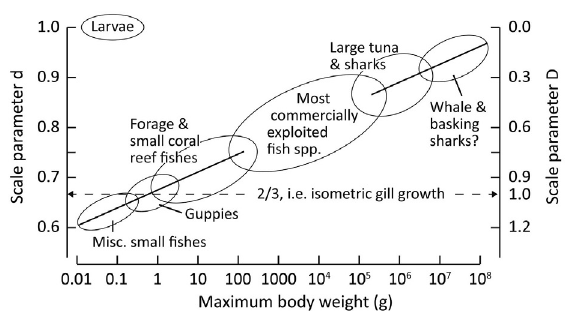
Fig. 3. – Showing that in fish, the parameter d and D are related to the maximum weight reached by various taxa (modified from Figure 2 in Pauly 1981); the straight line is based on the relations d = 0.674 + 0.0357(log(W )), with live weight in max